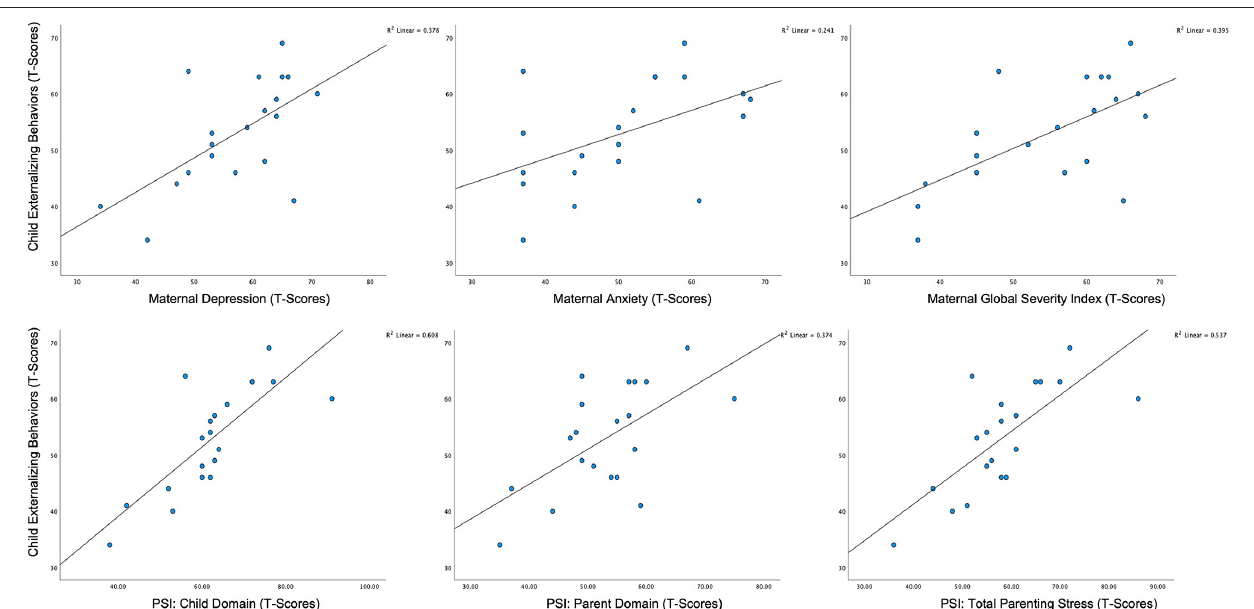
FIGURE 3 | Scatterplots of associations between child externalizing behavior and maternal mental health status and parenting